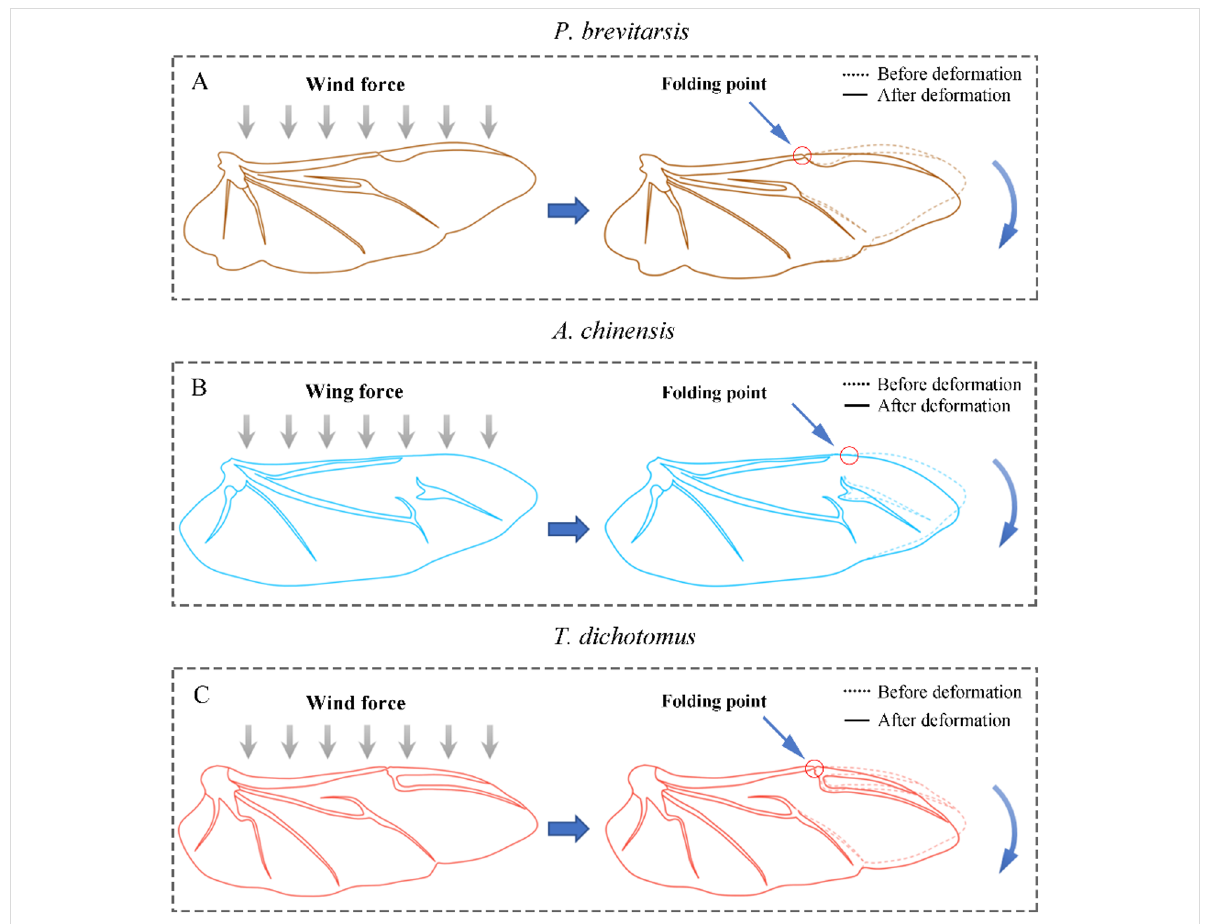
Figure 6: Schematic diagram of passive deformation of the hind wings of the three